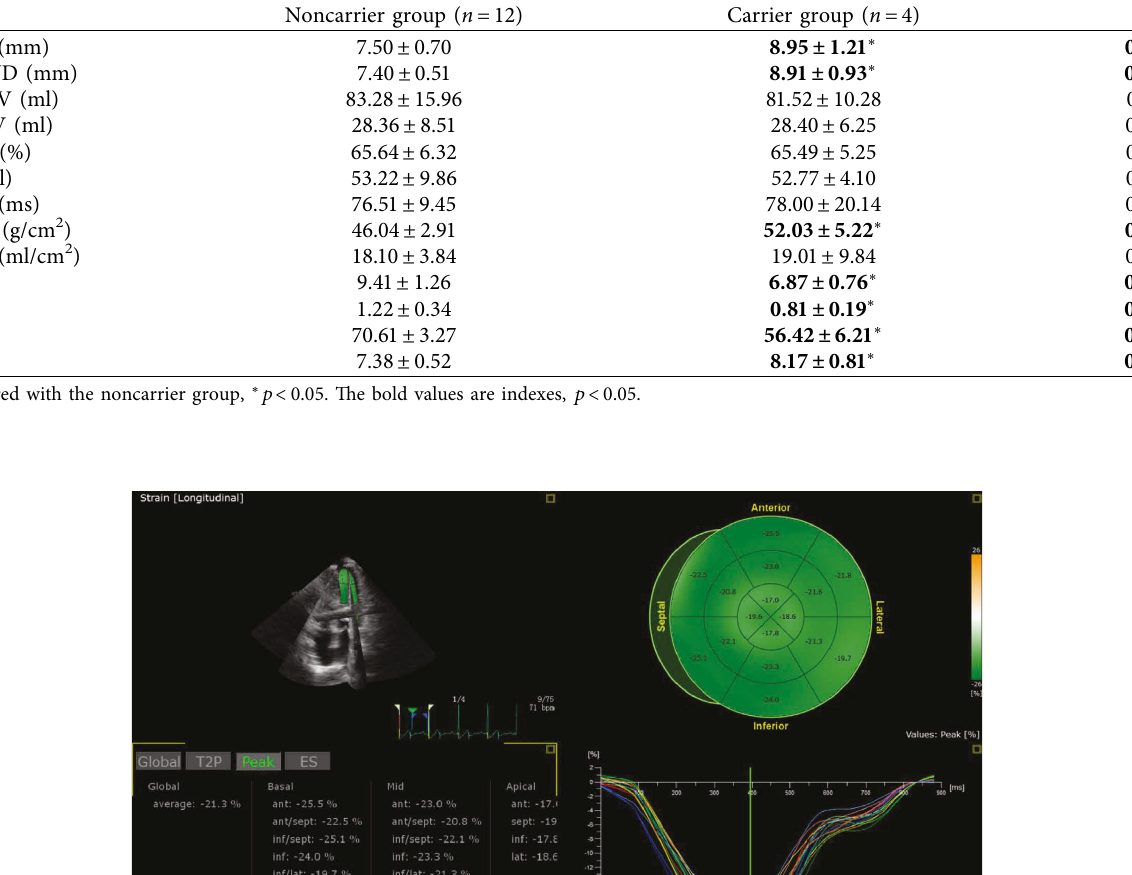
Table 2: Comparison of two-dimensional echocardiography between the two groups ( x ± s ).